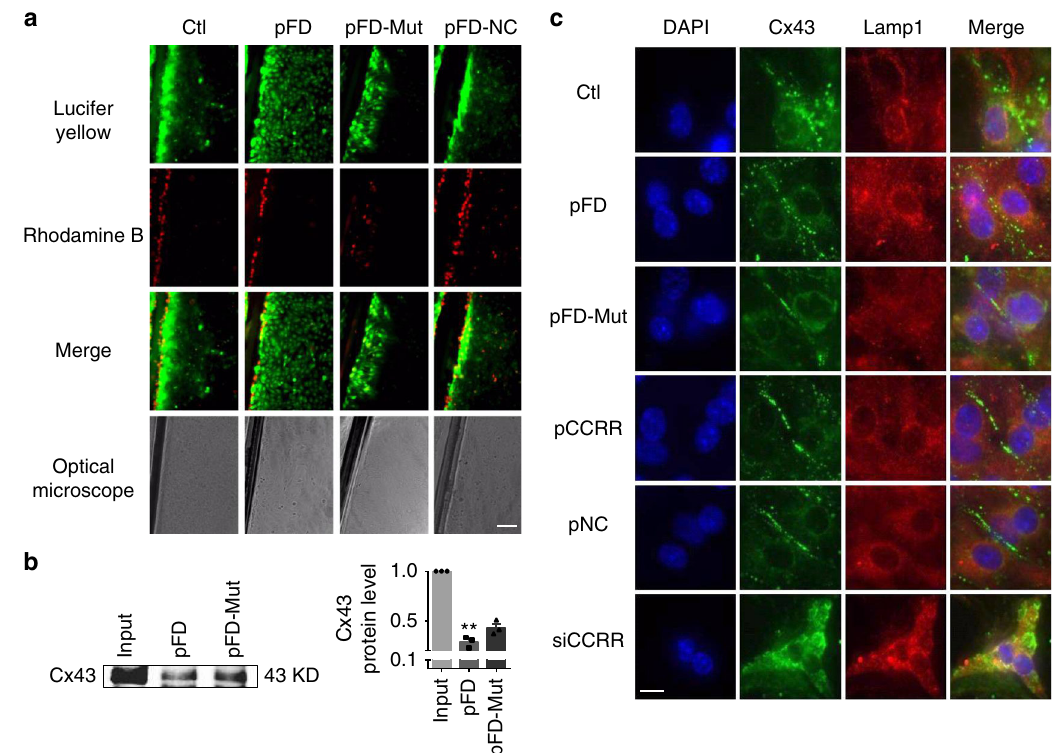
Fig. 9 Functional domain of CCRR (FD) improves gap junction communication. a Effects of conserved FD on gap junction communication assessed by dye transfer techniques in AC16 human adult ventricular cells (200× magni fi cation). AC16 cells were loaded with a diffusible fl uorescent dye (Lucifer yellow), and the diffusion of the dye was monitored under a laser confocal microscope. Note that transfection of pFD for FD overexpression signi fi cantly promoted, whereas pFD-Mut did not alter, the diffusion of Lucifer yellow among AC16 cells (green). The high molecular weight marker dye conjugate Rhodamine B was used as a negative control (red). Similar data were acquired from another three experiments. b Effect of FD on the interaction between Cx43 and CIP85, as reported by co-immunoprecipitation in cultured NMVMs transfected with the plasmid carrying the FD (pFD) for overexpression. Note that the protein level of Cx43 co-immunoprecipitated by CIP85 antibody was signi fi cantly reduced. pFD-Mut: the mutant construct of pFD with nucleotide substitution to the putative binding site of CCRR or FD to CIP85. ** P < 0.01 pFD vs. pFD-Mut; n = 3 batches of cells for each group. (Mean ± SEM; ANOVA followed by Dunnett ’ s test for multiple group comparisons, and Student t test for two group comparisons). c Effect of CCRR or FD on the recruitment